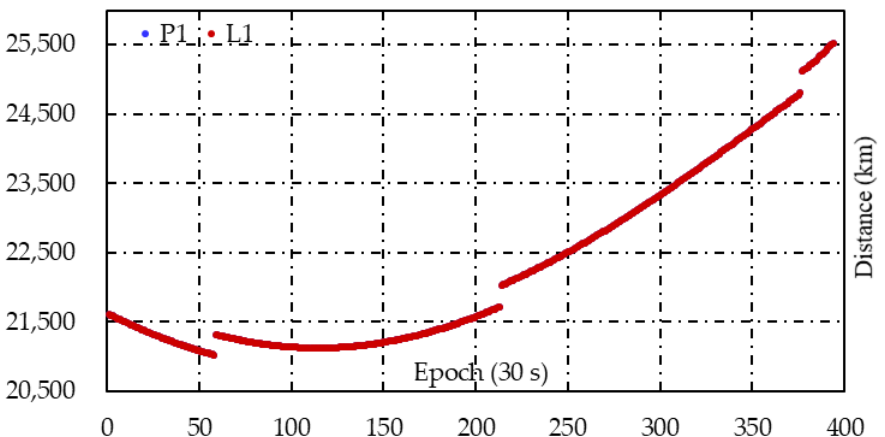
Figure 1. Original P1 and L1 observation time series of G02 on DOY 001, 2020, for CUT0 under clock jump of type I.